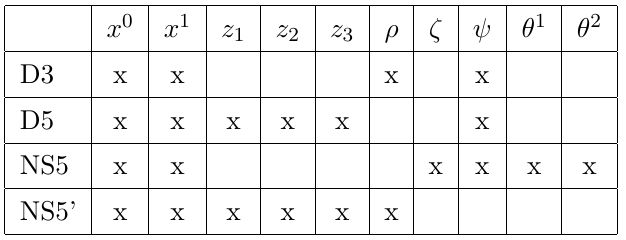
-BPS brane intersection T-dual to the brane intersection depicted in table 4, realising a Table 6 . 1 8 D3-brane box model. ( x 0 , x 1 ) are the directions where the field theory lives, ( z ρ is the direction where the NS5-branes are located, ζ and θ i are respectively the radial coordinate of AdS and the angles that parameterise the S 2 , and ψ parameterises the S 1 generated upon the 3 dualisation, where the NS5’-branes are located. ( ρ, ψ ) are thus the two directions of the brane box.